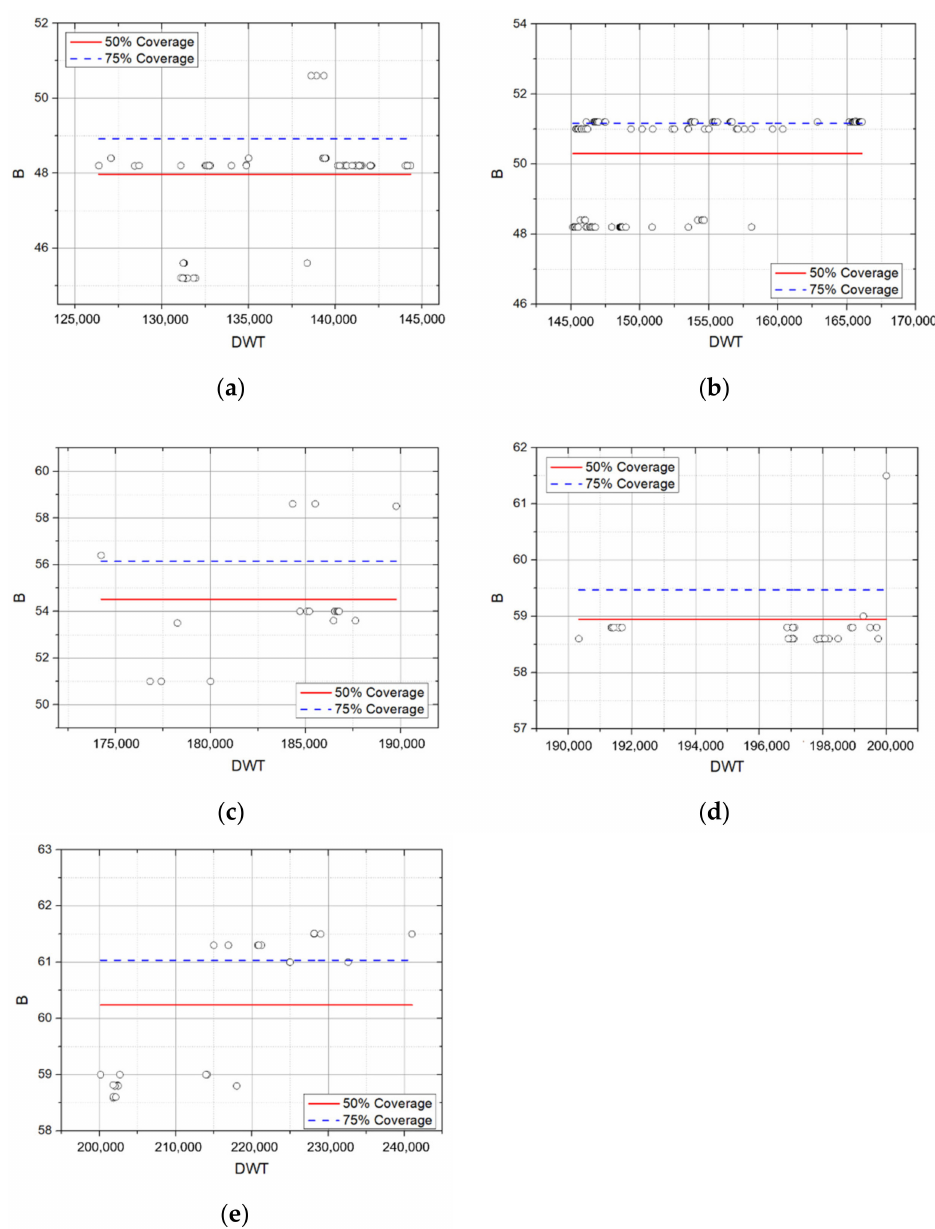
Figure 15. Results of regression analysis. ( a ) Deadweight tonnage (DWT)-breadth (B) graph of Cluster 3 (125,000–145,000 DWT); ( b ) DWT-B graph of Cluster 3 (145,000–170,000 DWT); ( c ) DWT-B graph of Cluster 3 (170,000–190,000 DWT); ( d ) DWT-B graph of Cluster 3 (190,000–200,000 DWT); ( e ) DWT-B graph of Cluster 3 (200,000–241,000